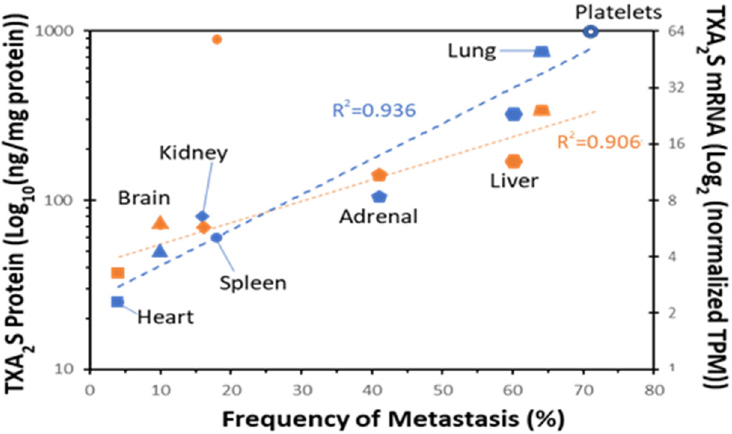
Figure 7. TXA 2 S expression is elevated in common sites of metastasis. TXA 2 S protein (blue) and RNA (Orange) expression was graphed against the frequency of metastasis from breast cancer (RNA expression from human protein atlas, metastasis data from [137]).